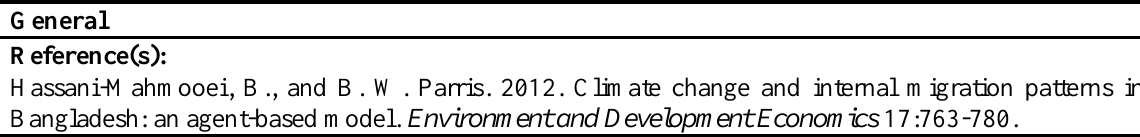
Fig. A1.3 Diagram drafted for the ABM described by Hassani-Mahmooei & Parris (2012); agents do not make explicit return decisions, but migrate from region to region and can thereby visit a region again at some point in the future Table A1.3 Standardized protocol for the ABM described by Hassani-Mahmooei &